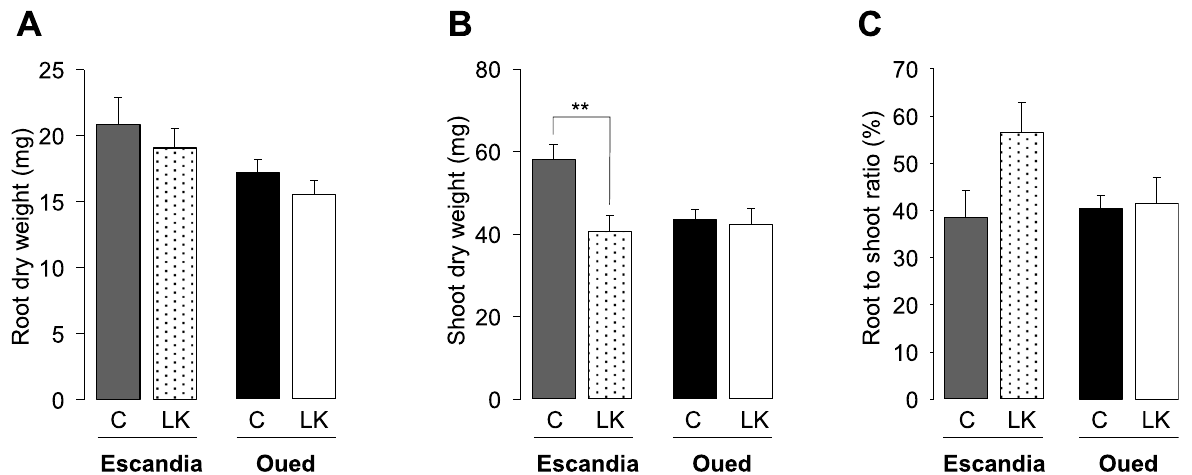
Fig. 3 Effects of K + shortage on root and shoot biomass in Escandia and Oued Zenati wheat seedlings. Escandia and Oued Zenati wheat seedlings were grown in rhizoboxes for 14 days in the same ionic conditions (control and low K + ) as in Fig. 2. A Root, and B shoot biomass (dry weight: DW), and C root to shoot DW ratio (calculated from A and B ). Means for both conditions in Oued Zenati). ** denotes statistically significant differences (Student t test; p <